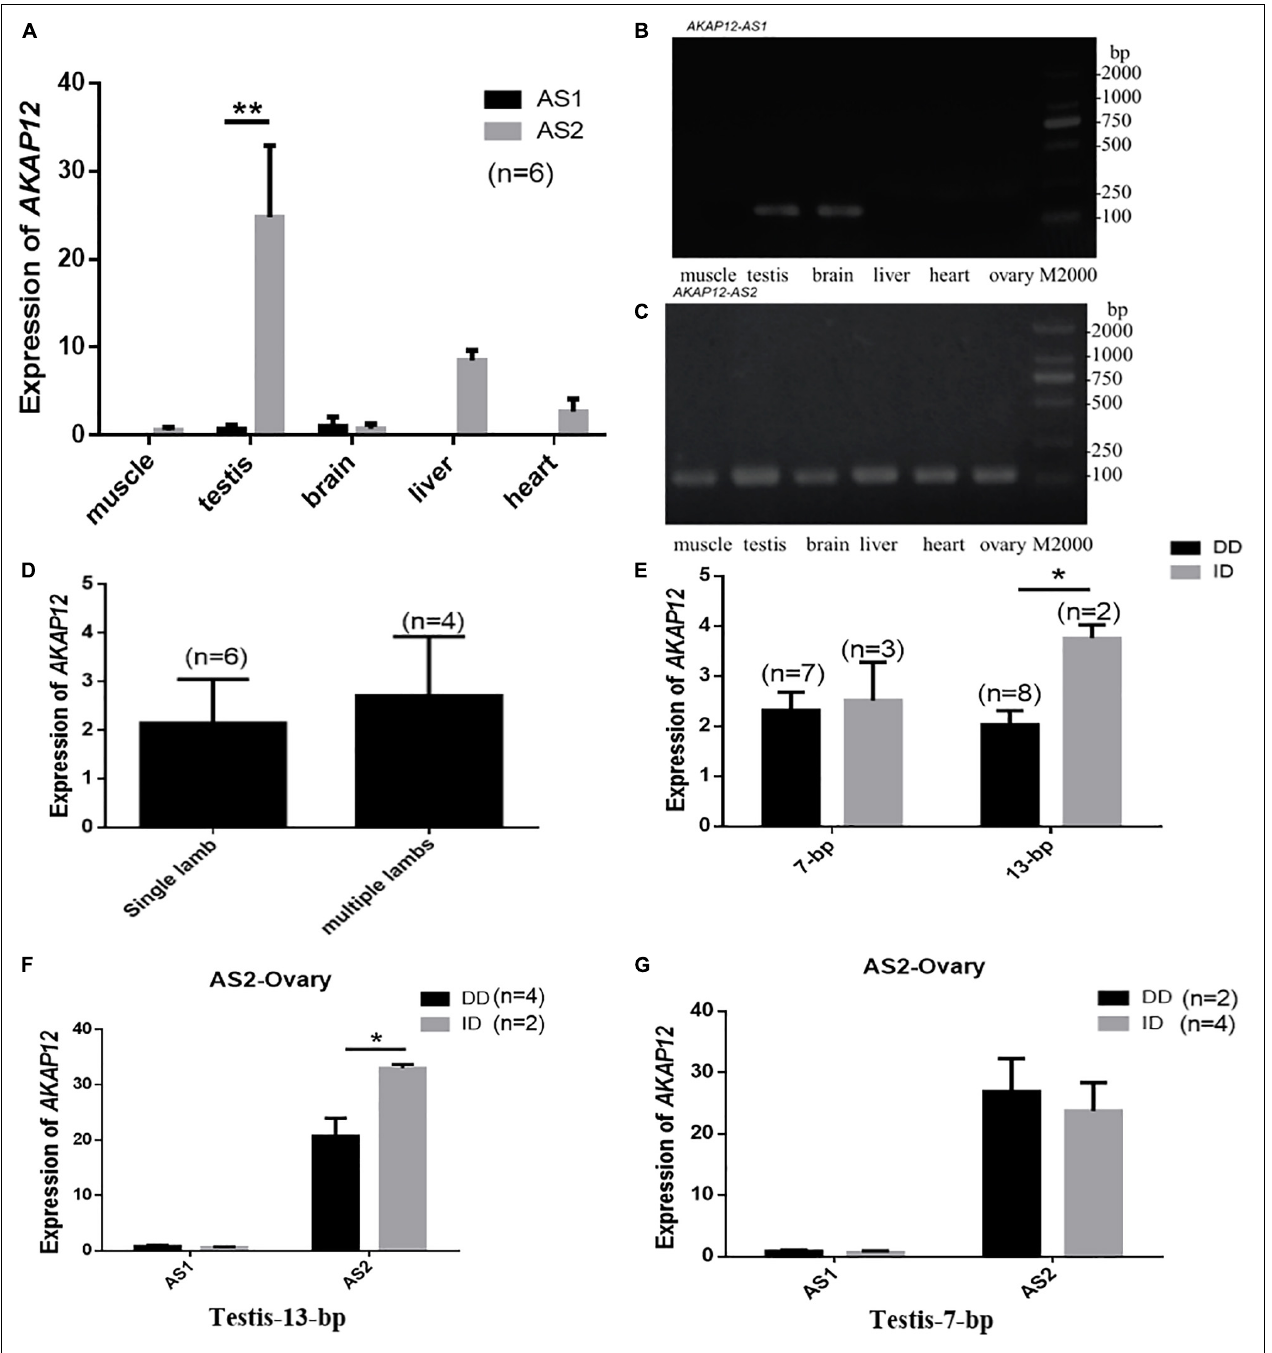
FIGURE 4 | AKAP12 mRNA expression patterns in Shaanbei white cashmere goat. (A) Differential expression of AKAP12-AS1 and AKAP12-AS2 in different tissues of male goats. (B) RT-PCR analysis of AKAP12-AS1 in different tissues. (C) RT-PCR analysis of AKAP12-AS2 in different tissues. (D) Differential expression of AKAP12 gene in ovary tissue of goats with single-lamb or multi-lambs. (E–G) The correlation between AKAP12 mRNA expression in the ovary and testis and different genotypes of the 7-bp and 13-bp indel locus. Data represent means ± SE. * P < 0.05, ** P < 0.01.